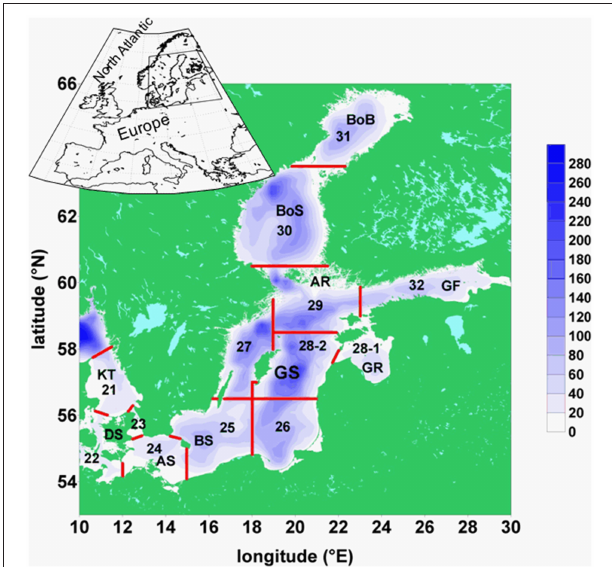
FIGURE 1 | Map of the Baltic Sea: Baltic Sea topography, its basins, and ICES subdivisions: BoB, Bothnian Bay; BoS, Bothnian Sea; AR, Archipelago Sea; GF, Gulf of Finland; GR, Gulf of Riga; GS, Gotland Sea; BS, Bornholm Sea; AS, Arkona Sea; DS, Danish Sounds; KT. Kattegat. The red lines separate the areas of ICES subdivisions, numbered from 21 to